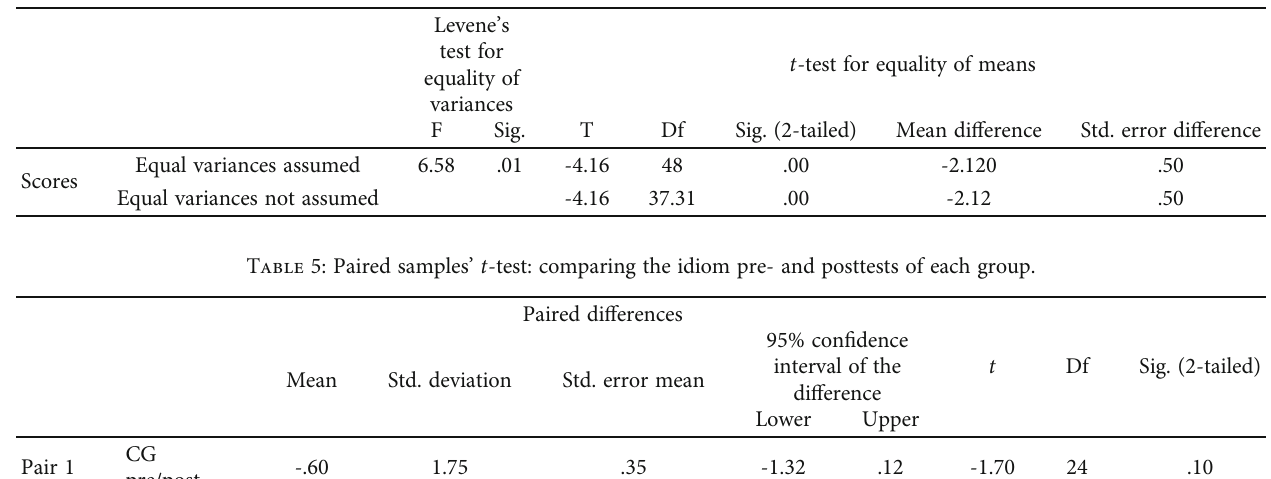
Table 4: Inferential statistics of the idiom posttests.